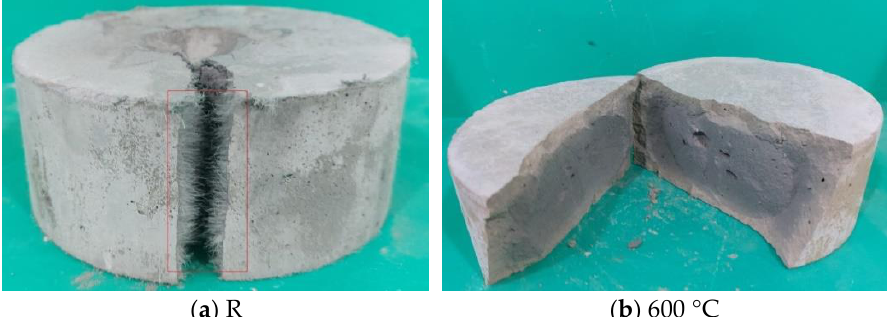
Figure 8. Physical appearance of PP fibers in the impact specimens before and after heating.